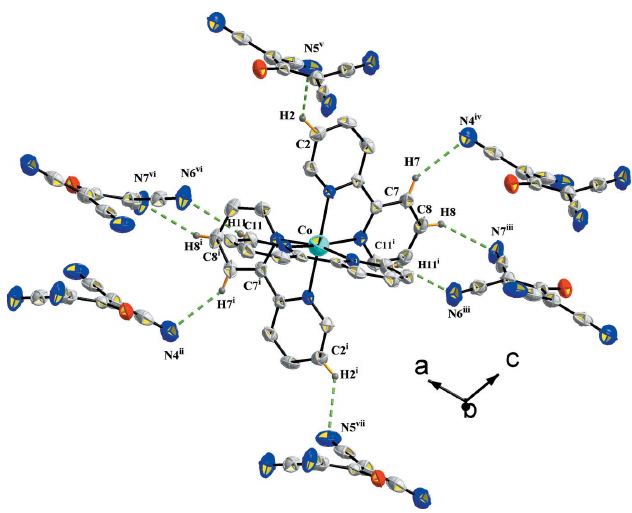
Figure 3 The hydrogen-bonding environment of the cation in the crystal of compound (I). Only H atoms involved in hydrogen bonding have been included. [Symmetry codes: (i) 1 (cid:3) x , y , 1 y + 1 , z ; (iv) 1 (cid:3) x , 1 (cid:3) y , 1 (cid:3) z ; (v) 3 2 (cid:3) y , (cid:3) 1 (vii) (cid:3) 1 + x , 3 + z .] 2 2 2